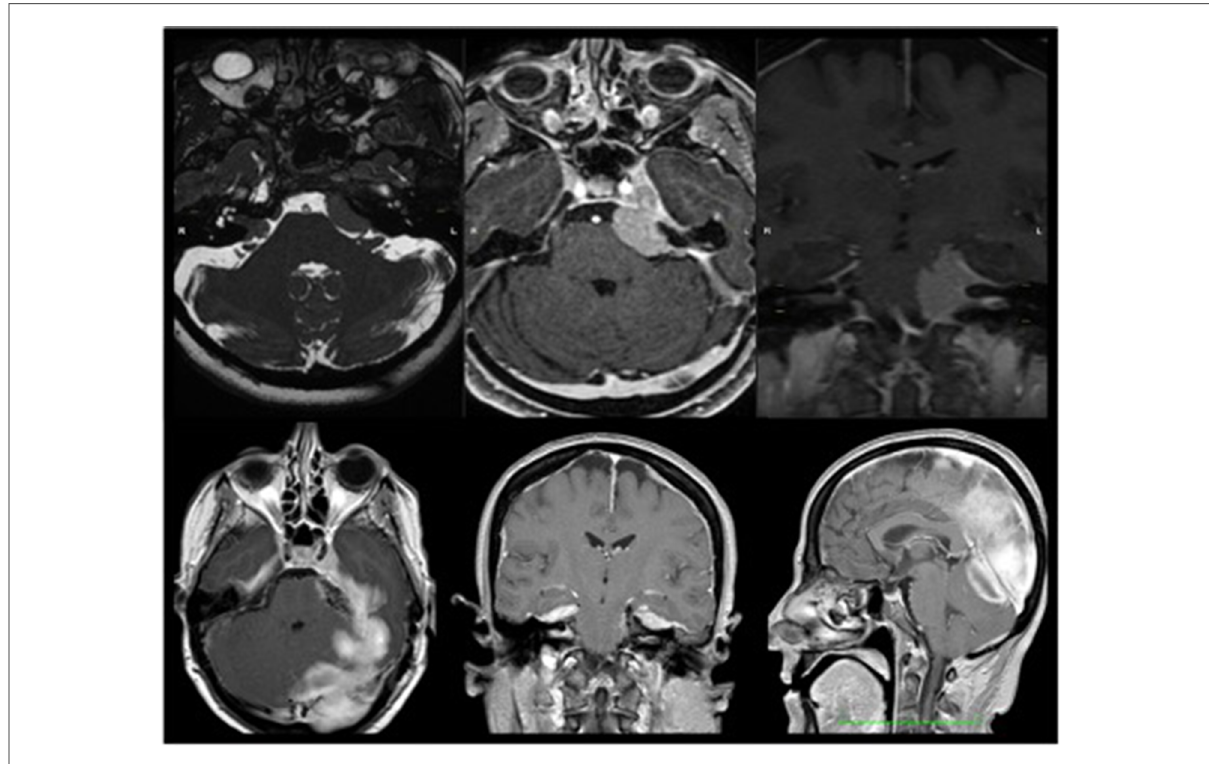
FIGURE 2 Illustrative case. Top row: preoperative images of magnetic resonance image (MRI) of the brain in sequences 3D-FIESTA, T1+Gad axial and T1+Gad coronal. Bottom row: postoperative image. MRI in T1+Gad in the three planes of